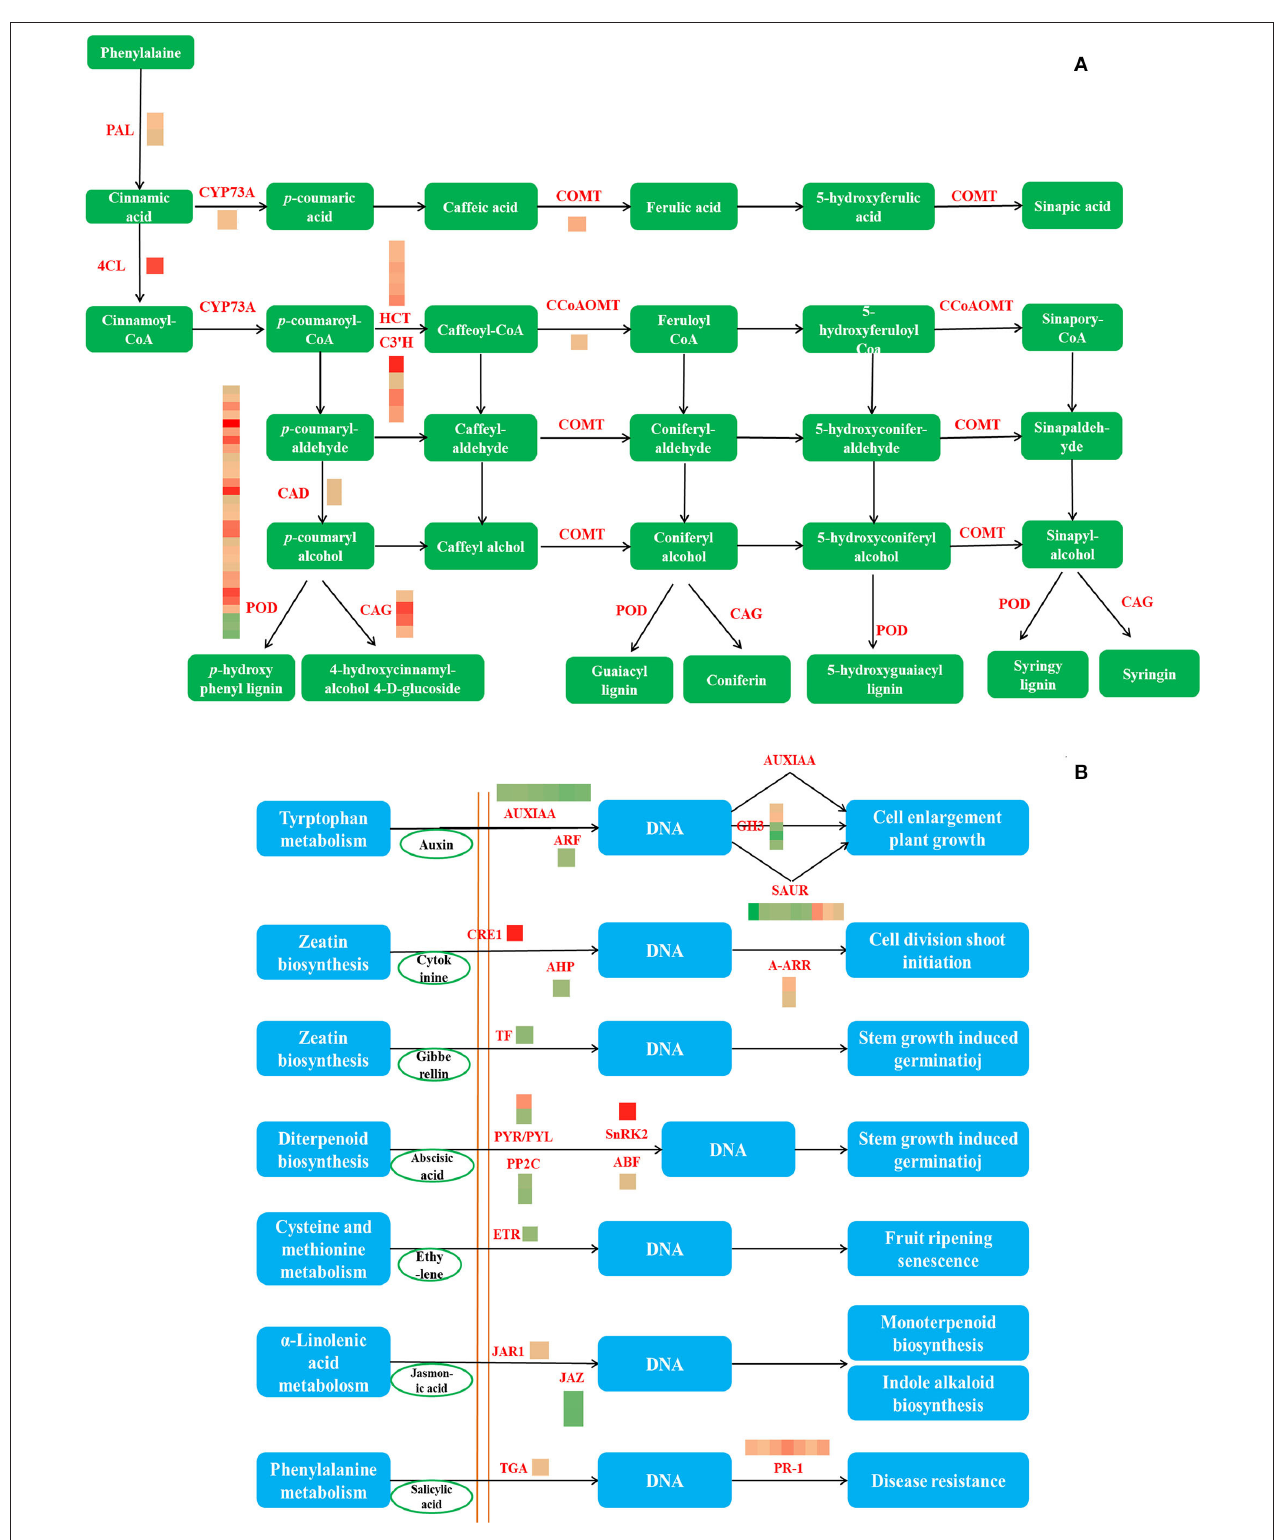
FIGURE 4 | The phenylpropane biosynthesis pathway and the DEGs involved in this pathway (A) (PAL, phenylalanine ammonia-lyase; 4CL, 4-coumarate–CoA ligase; CYP73A, trans-cinnamate 4-monooxygenase; CAD, cinnamyl-alcohol dehydrogenase; COMT, caffeic acid 3-O-methyltransferase; POD, peroxidase; CCoAOMT, caffeoyl-CoA O-methyltransferase; CAG, coniferyl-alcohol glucosyltransferase) and The plant hormone signal transduction and the DEGs involved in this pathway